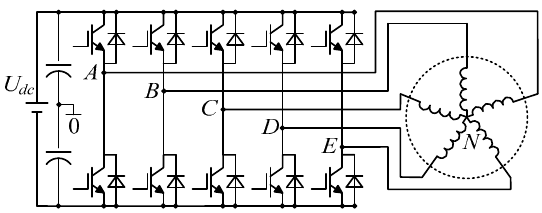
Figure 1. Five-phase PMSM drive system.